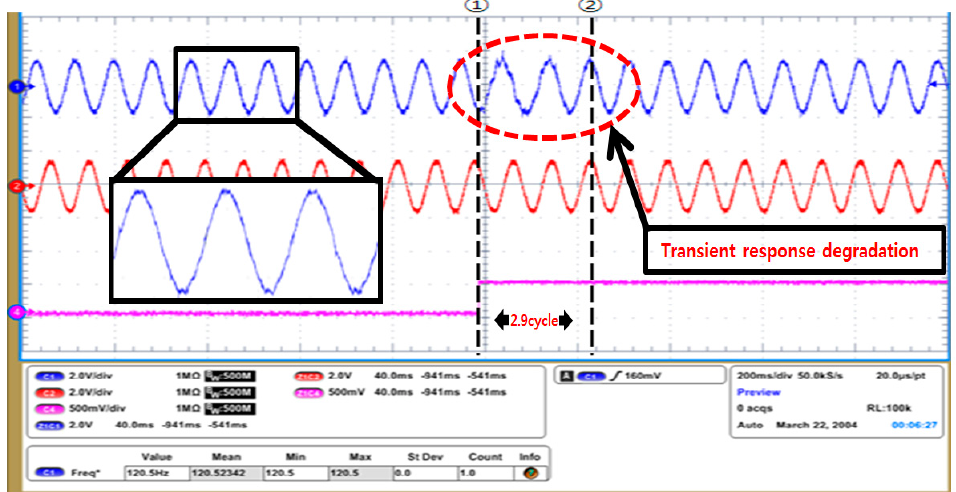
Figure 22. Experimental results in Case III. (SBGS ⟶ GS Mode) (From top to bottom: Measured a -phase inverter output voltage and grid voltage (200 V/div), GS status signal (0 or 1)), ( ① : starting point of synchronization. ② : finalized point of synchronization).